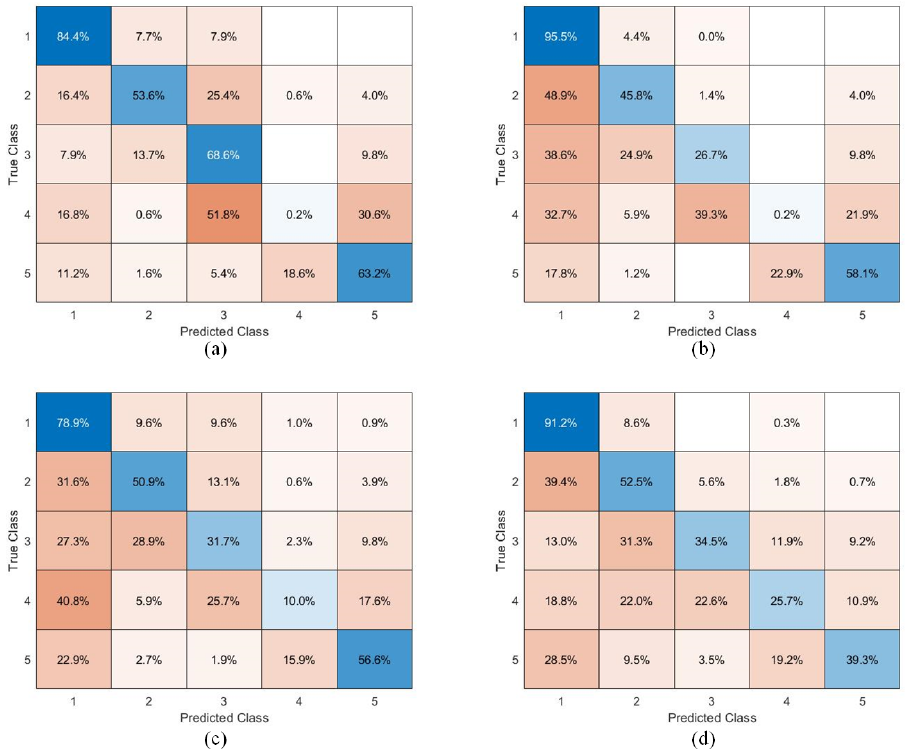
Figure 8. Confusion matrices of the best-performing ML recipes for the non-linear wear state classes: